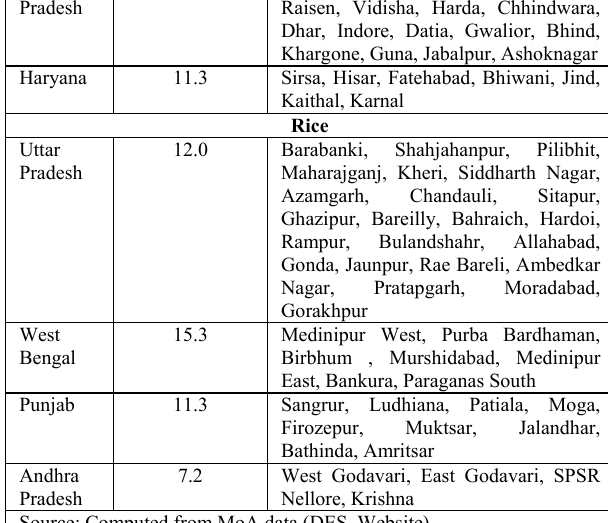
Source: Computed from MoA data (DES, Website).